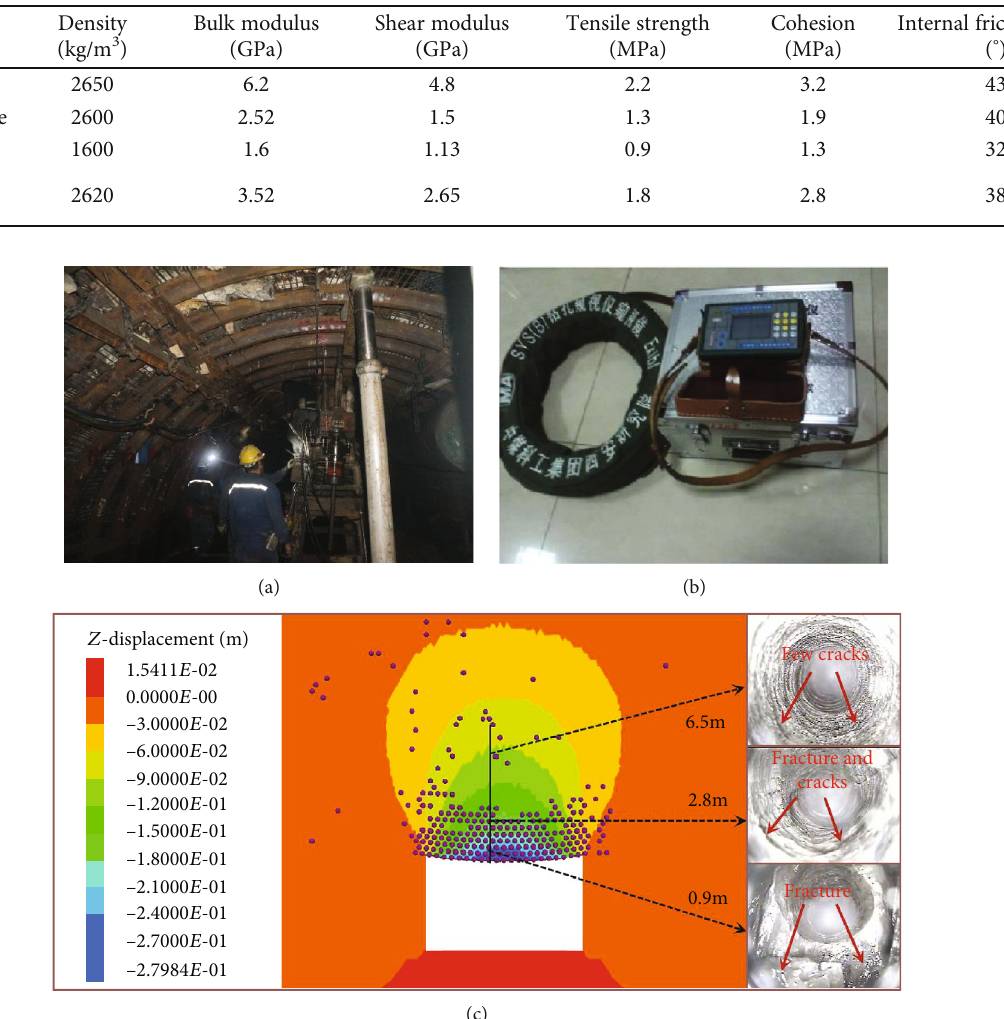
Figure 8: Crack development in roadway roof. (a) Drill hole at roadway roof. (b) Rock strata detection recorder. (c) Roadway roof